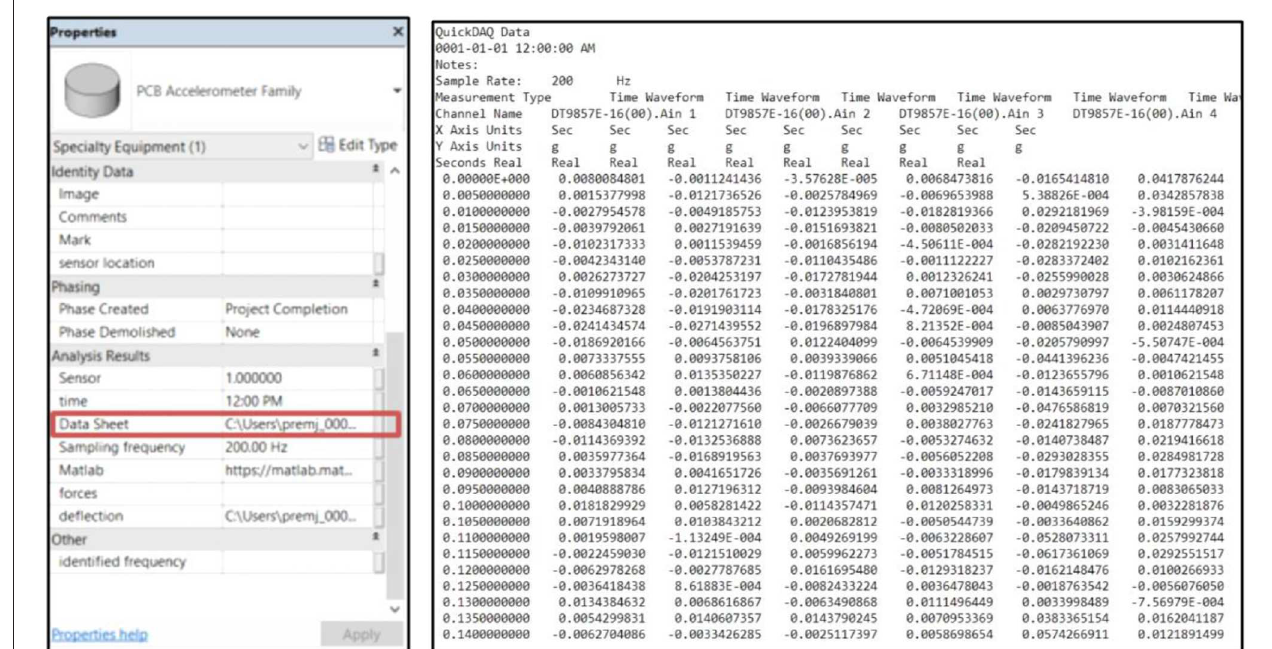
FIGURE 8 | DAQ file containing raw and unprocessed data.